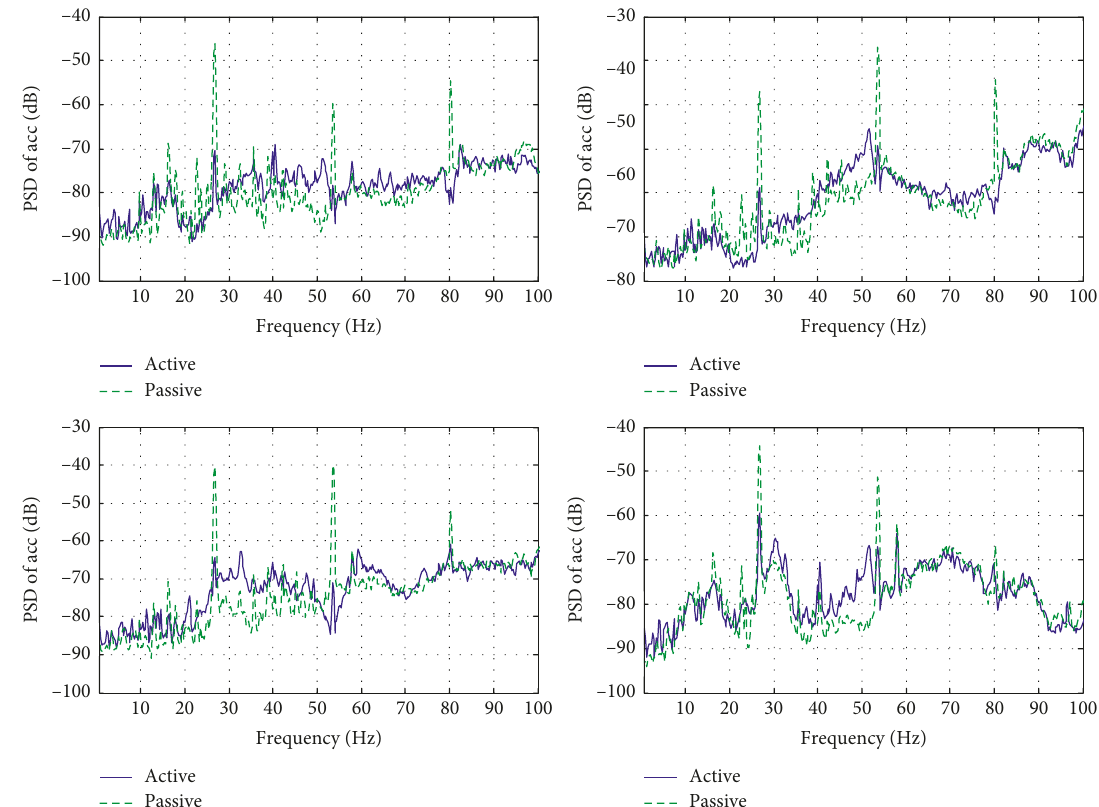
ref (cid:30) 1 g. (b) Pt. #2, dB ref (cid:30) 1 g. (c) Pt. #3, dB ref (cid:30) 1g. (d) Pt. #4,